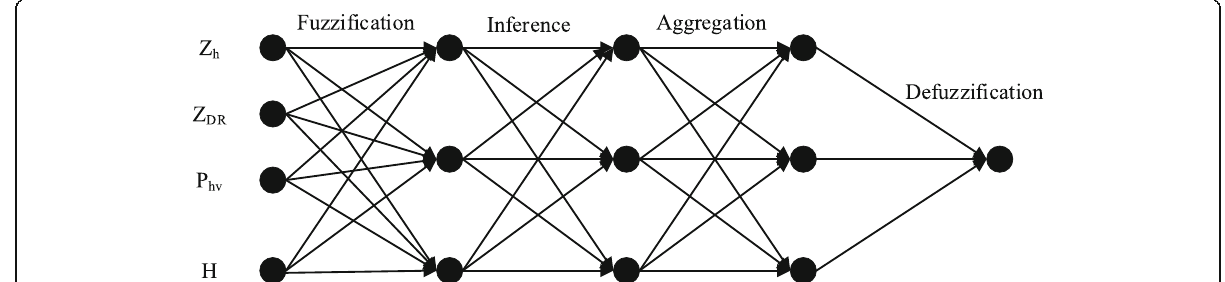
Fig. 1 The structure of the fuzzy logic classifier corresponding to the rainfall pattern